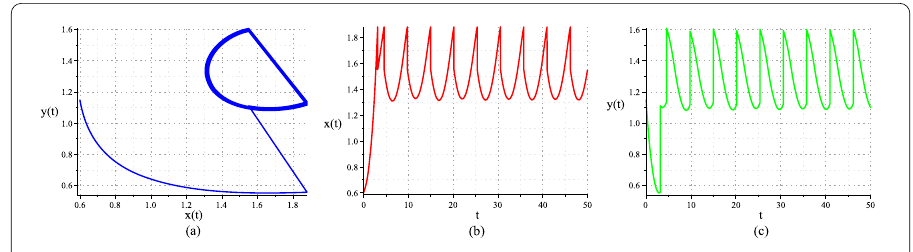
Figure 5 Numerical simulation of Example 2. (a) Phase portrait of x ( t ) and y ( t ) on h 2 = 1.88. (b) Time series of x ( t ). (c) Time series of y ( t ).